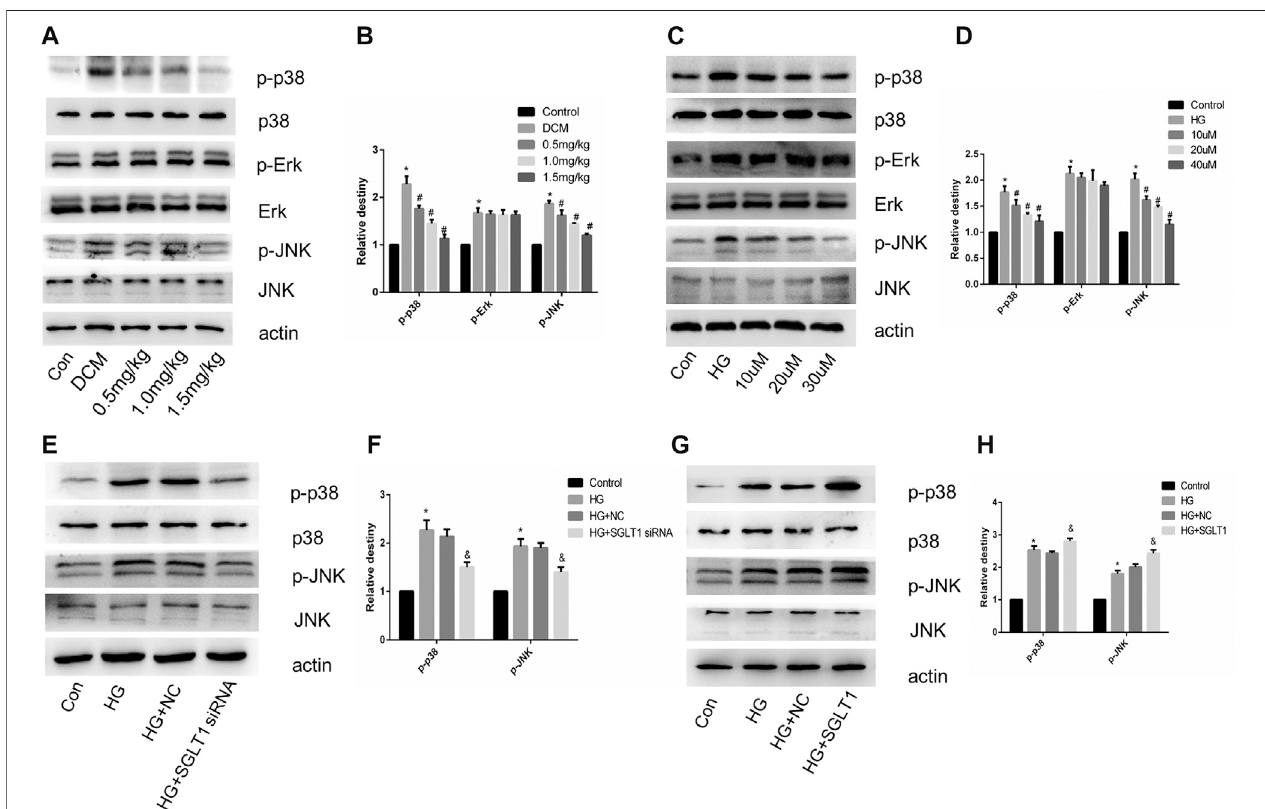
FIGURE 9 | SGLT1 in fl uenced apoptosis in DCM via the JNK and p38 pathway. (A – B) Expression of p-p38, p-Erk and p-JNK in rats (n (cid:1) 10). * p < 0.05 compared withthecontrolgroup; # p < 0.05comparedwiththeDCMgroup.Experimentswereperformedintriplicate. (C – H) Westernblotofp-p38,p-Erkandp-JNKinH9C2cells. * p < 0.05 compared with the control group; # p < 0.05 compared with HG group. Experiments were performed in